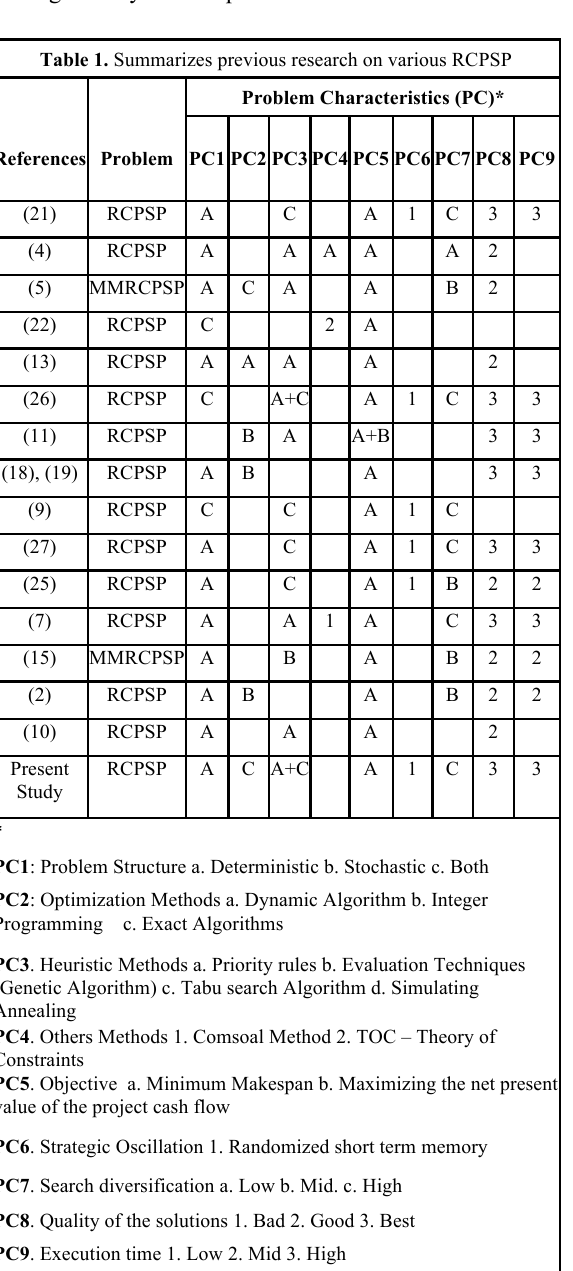
Figure 1. Precedence activity-on-node